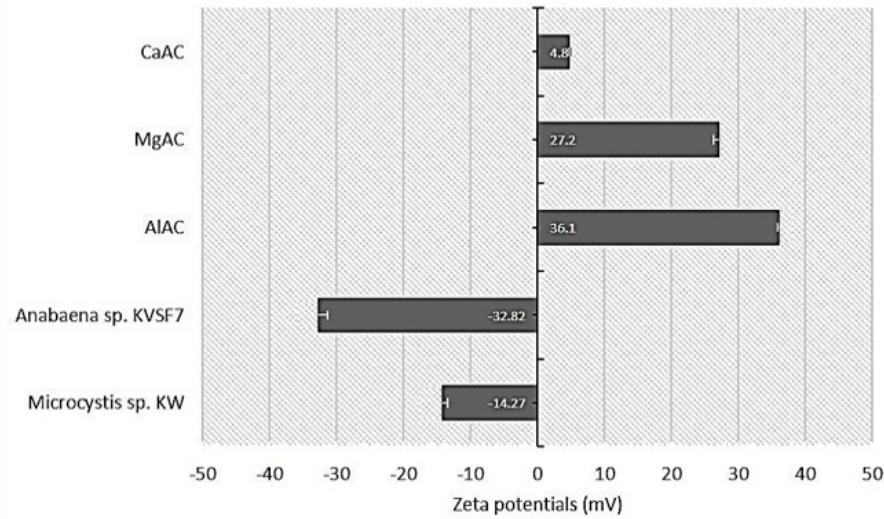
Figure 4. Zeta potentials of two cyanobacterial species (M.S. and A.S.) and three types of AC (MgAC, CaAC, and AlAC). The standard deviations of the mean ( n = 3) are represented by the error bars. A p < 0.05 value is considered to represent significant difference.